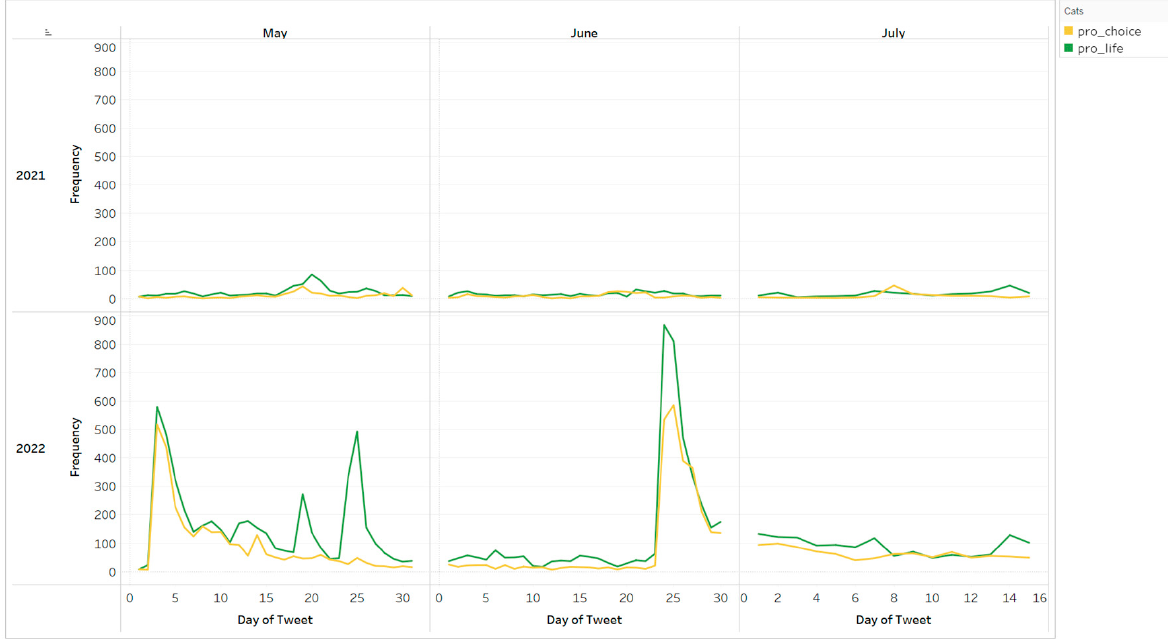
Figure A2. Number of tweets Roe v Wade sent 1 May–15 July 2022, divided by state population.